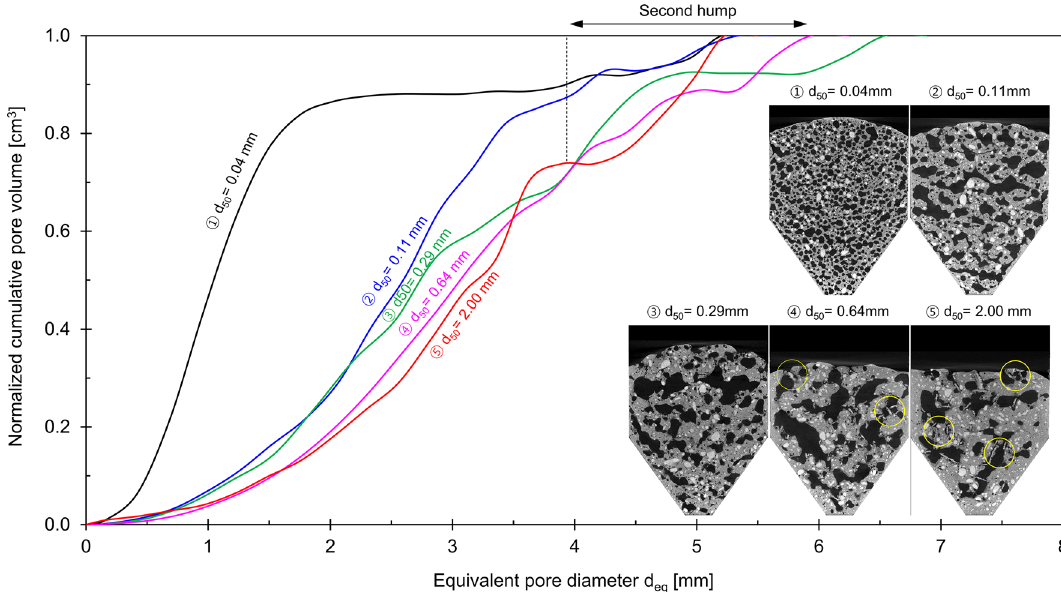
Figure 6. X-ray CT images and normalized cumulative pore size distributions extracted from the CT images for cement–water–aluminium–bentonite specimens involving five different aluminum chip sizes. Images gathered at the terminal volume expansion stage under constant pressure (open). All tests: water-cement mass ratio μ WC = M W /M C = 100%, aluminium–cement mass ratio μ AC = M A /M C = 4%, and bentonite-cement mass ratio μ BC = M B /M C =